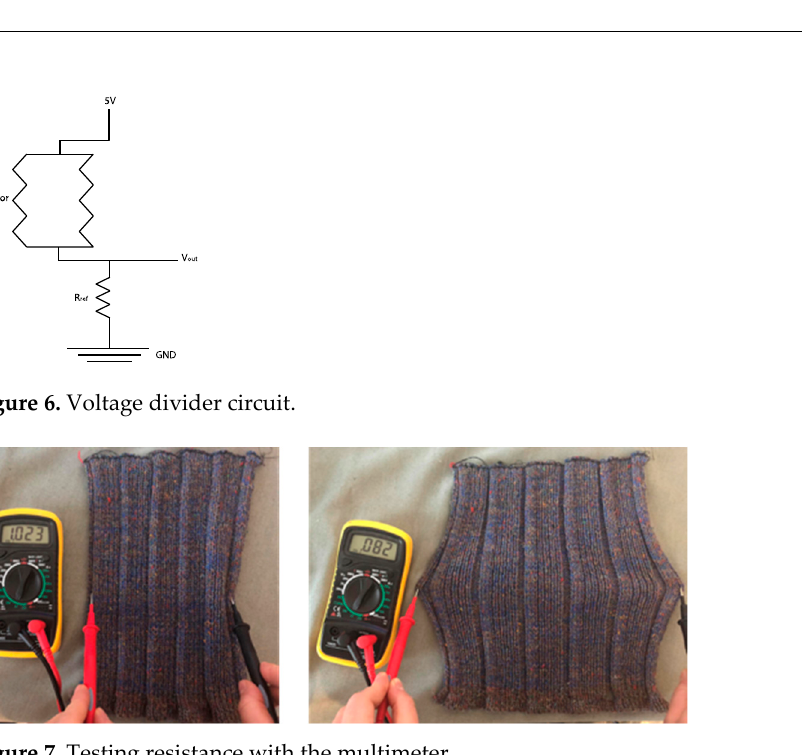
Figure 7. Testing resistance with the multimeter.